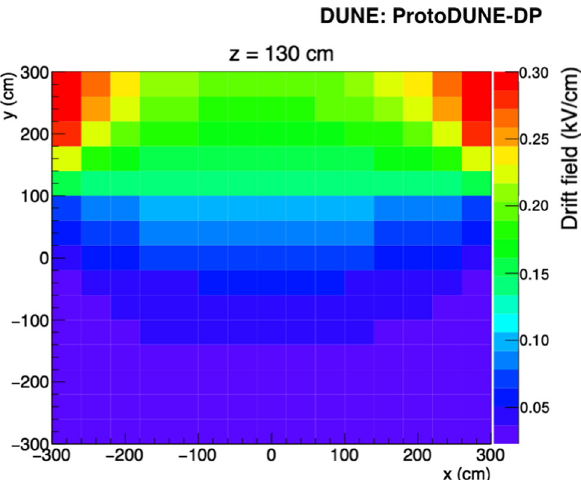
Fig. 3 Map of the drift field in ProtoDUNE-DP with cathode at − 50 kV simulated using COMSOL. A particular plane of the active volume is shown (vertical plane at 130cm from a field cage wall). The drift direction is along the y-axis and the color scale represents the electric field strength. The discontinuity at y ∼ 100cm is due to the HV failure described in the